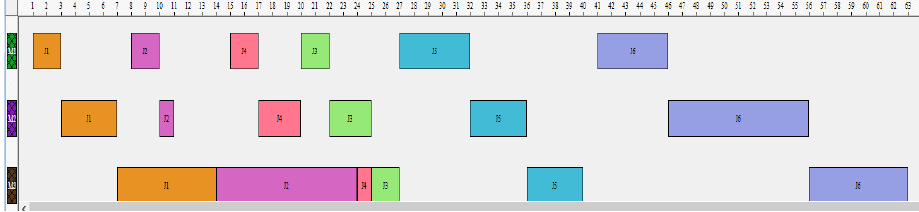
Figure 3. Gantt chart of the best solution with six jobs by